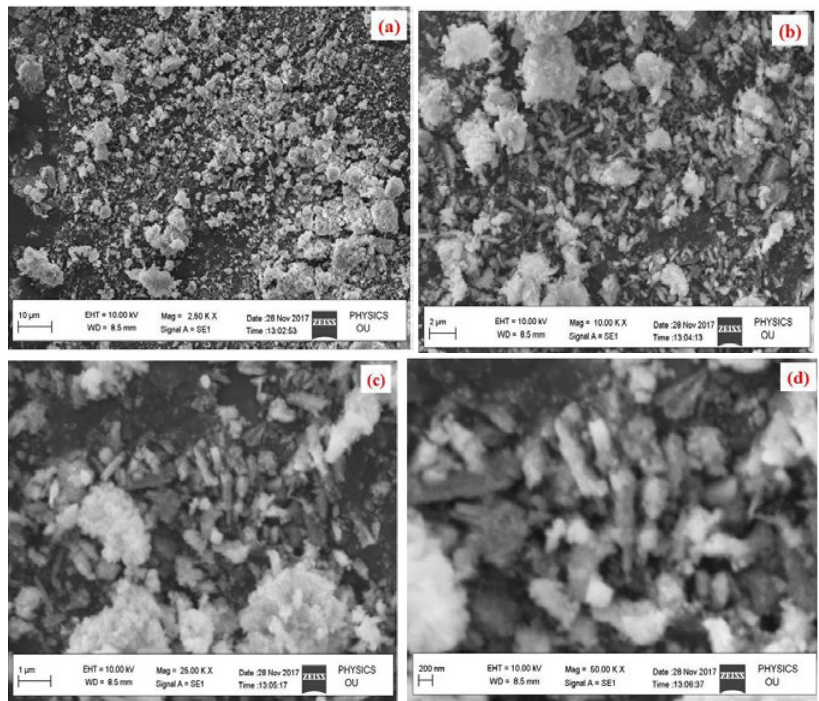
Fig. 4. X-ray diffraction patterns for undoped and doped ZrO Fig. 4 X-ray diffraction patterns for undoped and doped ZrO 2 NPs.